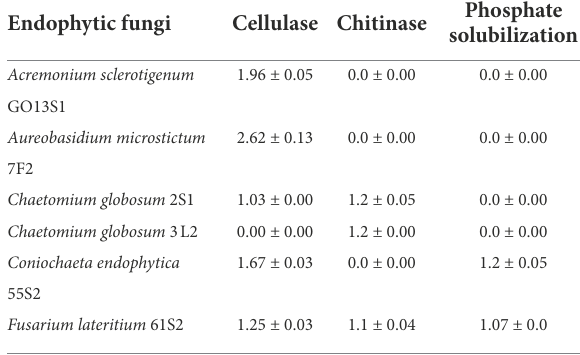
The means halo zone diameter/ colony diameter of three replications ± standard deviation is